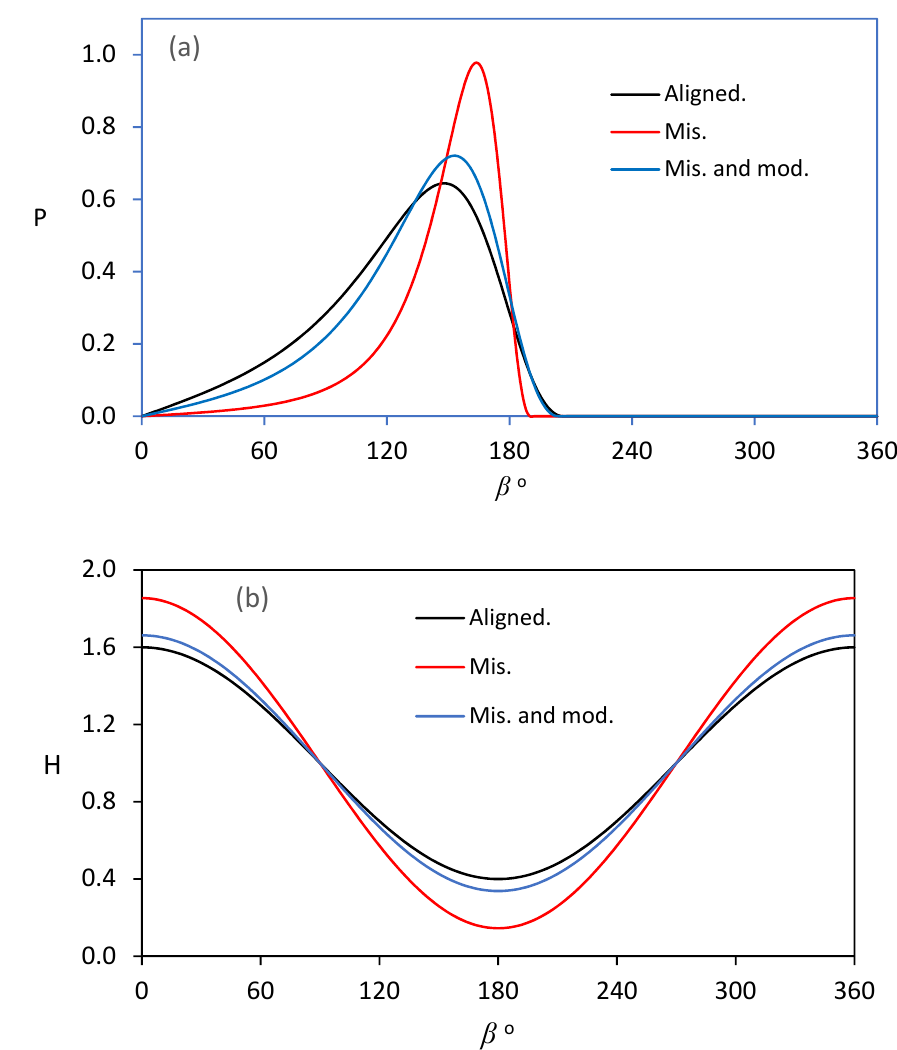
Figure 8. Effect of misalignment and profile modification on ( a ): pressure variation and ( b ): film thickness at the section of maximum pressure.